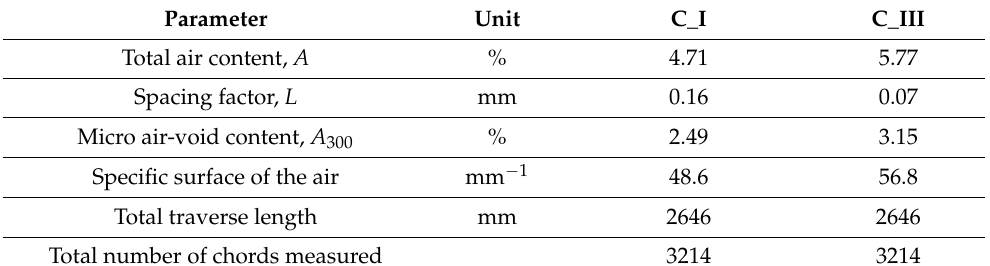
Table 10. The average values of the parameters characterizing air voids and their spacing.